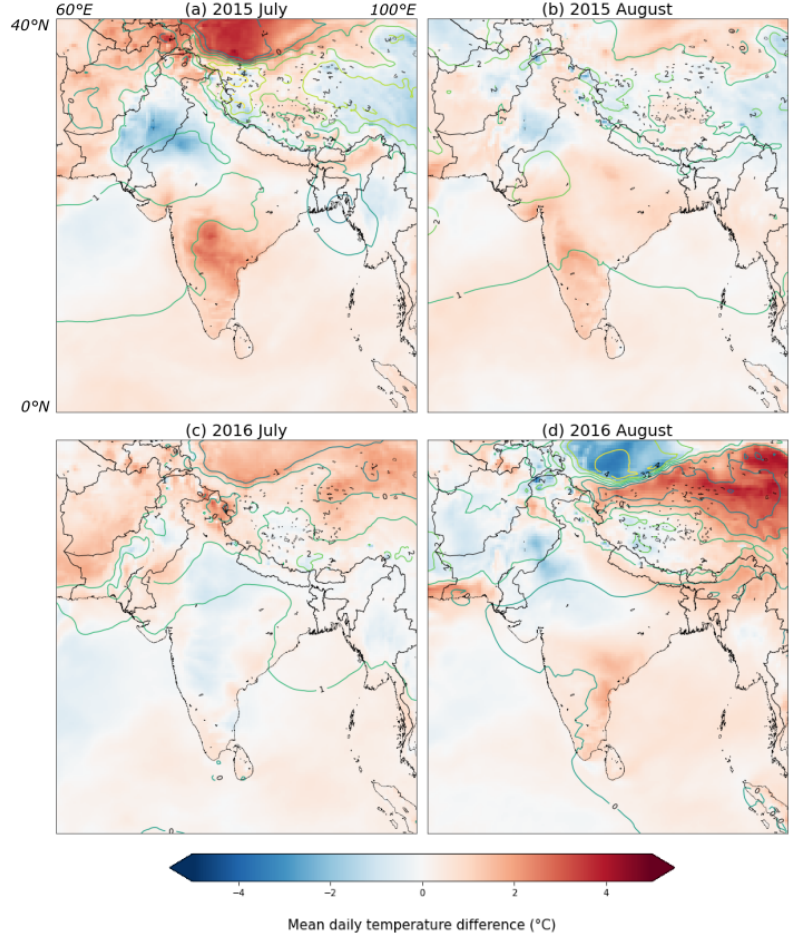
Figure 8. The anomaly behavior of the variables temperature (°C) and mean sea level pressure (hPa) over the whole ISM region. The mean monthly difference of temperature and mean sea level pressure is displayed for ( a ) July 2015, ( b ) August 2015, ( c ) July 2016, and ( d ) August 2016, calculated by subtracting the 2015 and 2016 monthly values, respectively, from the 40-year climatology period of 1979 to